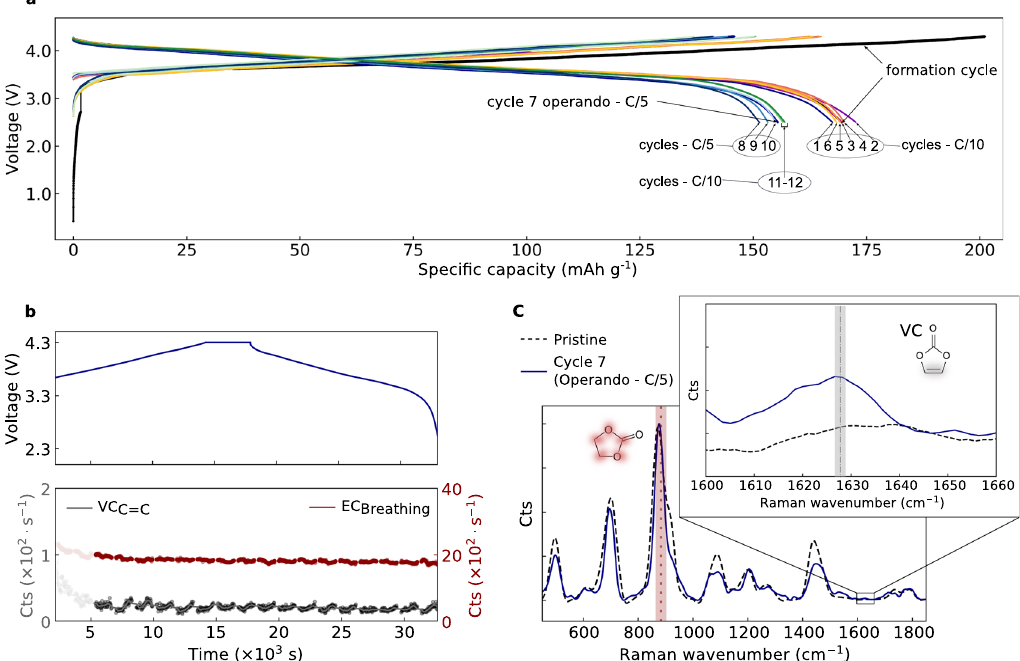
Fig. 6 Long-term cycling and Raman analysis. a Charge/Discharge voltage pro fi les of a Li-ion pouch cell (anode: graphite, cathode: NMC811, electrolyte: LP57 without VC additive) cycled at C/10 and C/5 rates. Labels 1 – 13 correspond to the number of each discharge cycle. b Operando analysis and time evolution of EC (red dashed line) and vinylene (grey dash-dotted line) Raman band intensities during cycle 7. Note that only Raman data for t > 5 × 10 3 s are shown, by which time the fl uid sampling has stabilised after reconnecting the cell to the HC- fi bre. The small periodic modulation in intensity is related to the fl uidic sampling interval. c Comparison between Raman spectra of pristine (not cycled) LP57 electrolyte (dashed line) and electrolyte extracted at the end of cycle 7. The inset in c shows the vinylene Raman band detected in the cycled